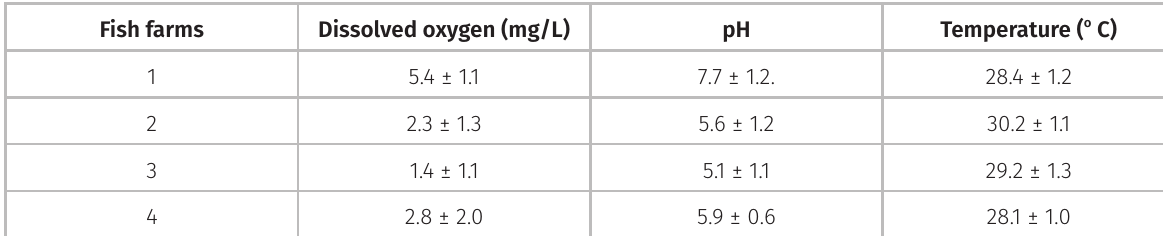
Table II. Parameters of water quality in tanks of four fish farms of Leporinus macrocephalus from the Rio Branco, in State of Acre, western Amazon region